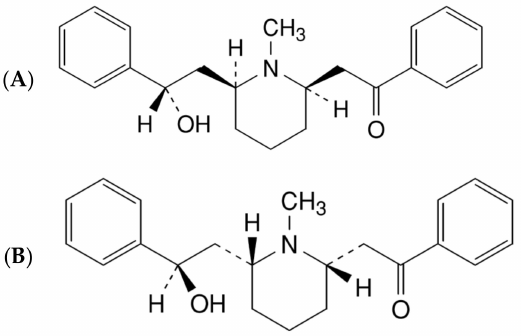
Figure 1. The computed properties of cis -lobeline, such as XLogP3-AA, hydrogen bond donor count, hydrogen bond accept count, topological polar surface area, were 3.8, 1, 3, and 40.5 Å 2 , respectively. Detailed information could be found in the PubChem database [10].